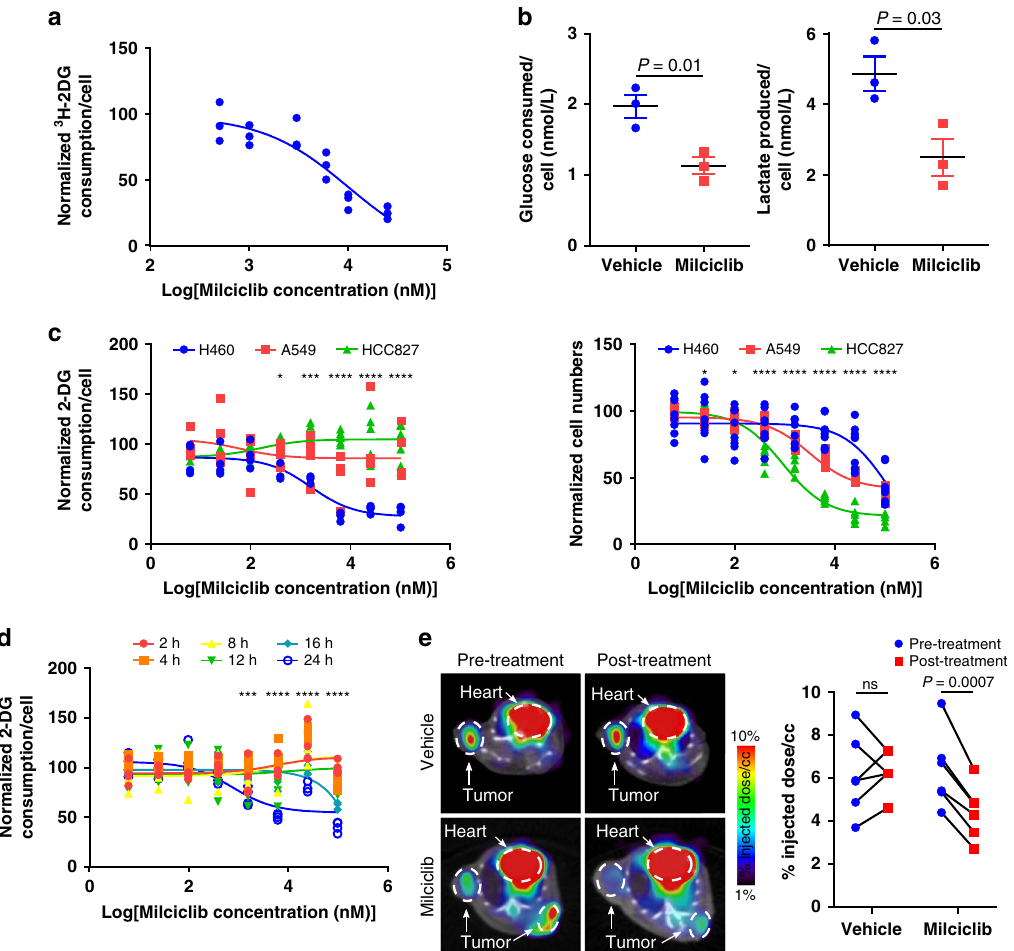
Fig. 3 Milciclib inhibits glucose consumption in H460 NSCLC cells. a Glucose consumption dose response curve measured by 3 H-2-DG consumption in H460 cells treated with Milciclib. n = 3. b Glucose consumption and lactate production measured from cell media by a biopro fi le basic analyzer in H460 cells treated with vehicle or Milciclib (10 μ M). n = 3. P values determined by unpaired t tests. c Glucose consumption (left) and cell growth (right) in H460, A549, and HCC827 cells treated with Milciclib. Glucose consumption: H460 and A549, n = 4; HCC827, n = 6. Cell growth: H460 and A549, n = 8; HCC827, n = 6. P values determined by a two-way ANOVA test. d Glucose consumption in H460 cells at different time points post-Milciclib treatment. n = 4. P values determined by a two-way ANOVA test. e 18 F-FDG PET images (left) and quanti fi cation (right) of H460 cell xenografts in mice pre- treatment and post-treatment with vehicle or Milciclib (30 mg kg -1 ). n = 6. P values determined by paired t tests. ns: not signi fi cant. * P < 0.05; *** P < 0.001; **** P < 0.0001. Data are plotted as mean ± SEM. treated with Milciclib compared to vehicle-treated cells (GLUT1, but not in A549 or HCC827 cells even though Milciclib-inhibited GLUT3, and Hexokinase 2 mRNA levels after 20 h: 76.9 ± 5.5%, cell growth in all three cell lines (Fig. 3c). Milciclib blocked glu- 42.5 ± 7.7%, and 67.8 ± 3.4% of control values, respectively; GLUT1, cose consumption in H460 cells after 16 h but before 24 h of GLUT3, and Hexokinase 2 mRNA levels after 24 h: 70.6 ± 4.9%, treatment (Fig. 3d). In vivo, Milciclib blocked glucose con- 64.5 ± 13.1%, and 47.2 ± 5.8% of control values, respectively; sumption in H460 cell xenografts by 30.4 ± 2.5%, as assessed Fig. 4a). Hexokinase 1 mRNA levels were higher at 20 h and lower using 18 F-FDG PET imaging, without affecting glucose con- sumption in the mouse brain, heart, liver, or muscle (Fig. 3e, at 24 h post-Milciclib treatment compared to vehicle-treated cells Supplementary Fig. 4). This suggests that Milciclib may inhibit (20 h: 121.1 ± 4.5% of control values; 24 h: 71.1 ± 7.1% of control glucose consumption selectively in cancer. Vehicle treatment did values; Fig. 4a). Milciclib decreased GLUT1, GLUT3, Hexokinase 1, not signi fi cantly affect H460 cell xenograft glucose consumption and Hexokinase 2 protein levels in H460 cells to 49.6 ± 6.1%, 84.3 ± (6.0 ± 6.0% increase) (Fig. 3e). Collectively, these data provide 2.6%, 93.5 ± 3.9%, and 85.3 ± 6.3% of control values, respectively strong evidence that Milciclib inhibits glucose consumption (Fig. 4b ; Supplementary Fig. 5). In A549 and HCC827 cells, Mil- selectively in H460 cells in cell culture and in vivo. ciclib had no signi fi cant effect on or slightly increased GLUT1, GLUT3, Hexokinase 1, or Hexokinase 2 protein levels (Supple- mentary Fig. 6). We further analyzed the effect of Milciclib on Milciclib blocks GLUT expression and glucose transport . glucose transport and hexokinase activity in H460 cells using a Cancer cells predominantly express SLC2A1 (GLUT1) and SLC2A3 FRET-based glucose reporter 36,37 . The rate of change in the FRET (GLUT3) to transport glucose across the cell membrane and Hex- ratio following removal of glucose alone measures the combined okinase 1 and Hexokinase 2 to phosphorylate glucose 34,35 . GLUT1, activity of the glucose transporters and the hexokinases 38 . The rate GLUT3, and Hexokinase 2 mRNA levels were lower in H460 cells NATURE COMMUNICATIONS| (2019) 10:5444